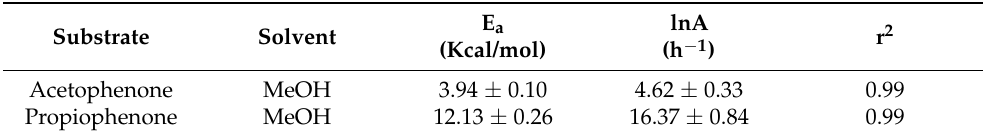
Table 6. Activation parameters E a (Kcal/mol) and lnA (h − 1 ), obtained from the Arrhenius plot of the catalytic hydrogenation of Acetophenone y Propiophenone over AlPO 4 -Sepiolite@ 1 , at the ex- perimental conditions showed in Figure 1.